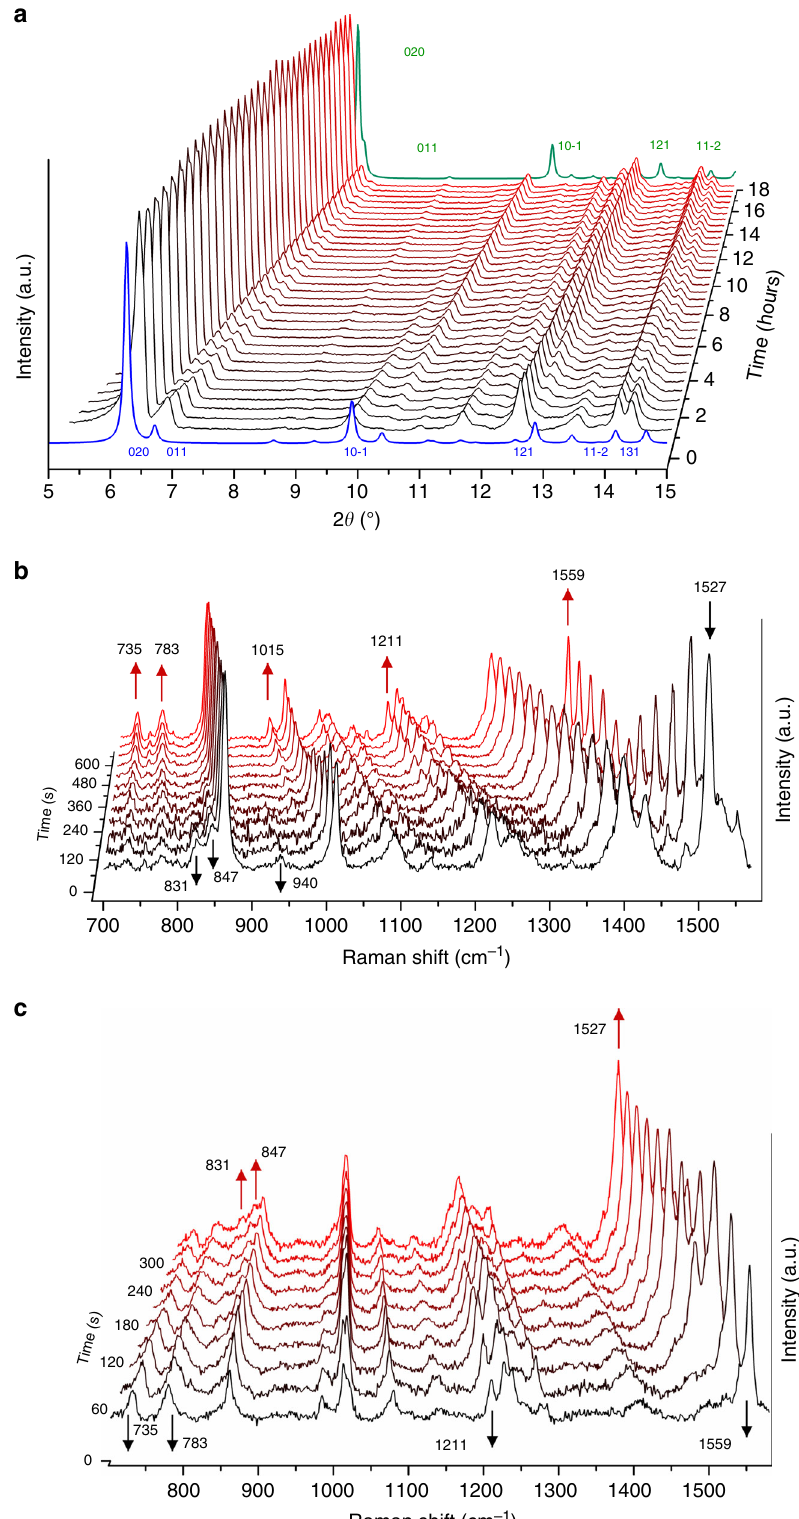
Fig. 2 Evidence for the conversion of 1 to 3 and the reversible retro-conversion. a Light-irradiated PXRD of 1 over a period of 17 h. The starting pattern is shown in black (front) and the last pattern is shown in red (back). The blue and green patterns are the simulated powder patterns of 1 and 3 , respectively. The key hkl re fl ections have been labelled. b Light-irradiated Raman (785 nm) of 1 . The fi rst and the last spectra are shown in black (0 s) and red (630 s), respectively. c Isothermal Raman (785 nm) of 3 at 180 °C. The fi rst and the last spectra are shown in black (0 s) and red (660 s),